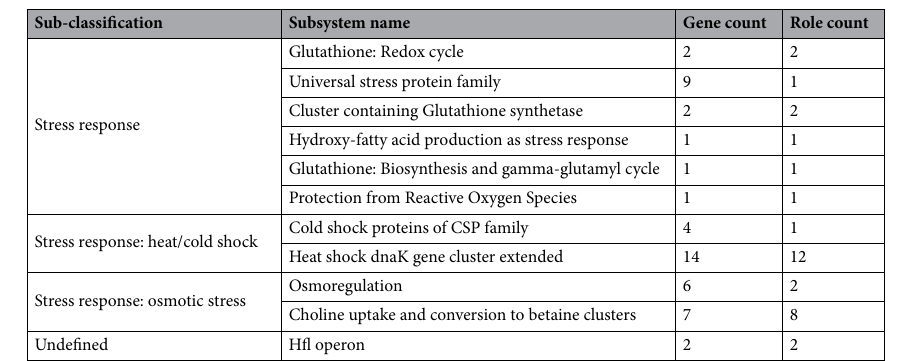
Table 4. Stress response and defense features in the genome of L. plantarum ATCC 202195-A. Subsystems analysis of the superclasses Stress Response, Defense, and Virulence, was performed using The Pathosystems Resource Integration Center (PATRIC) 35 , and Rapid Annotations Using Subsystems Technology (RASTtk) 25 for